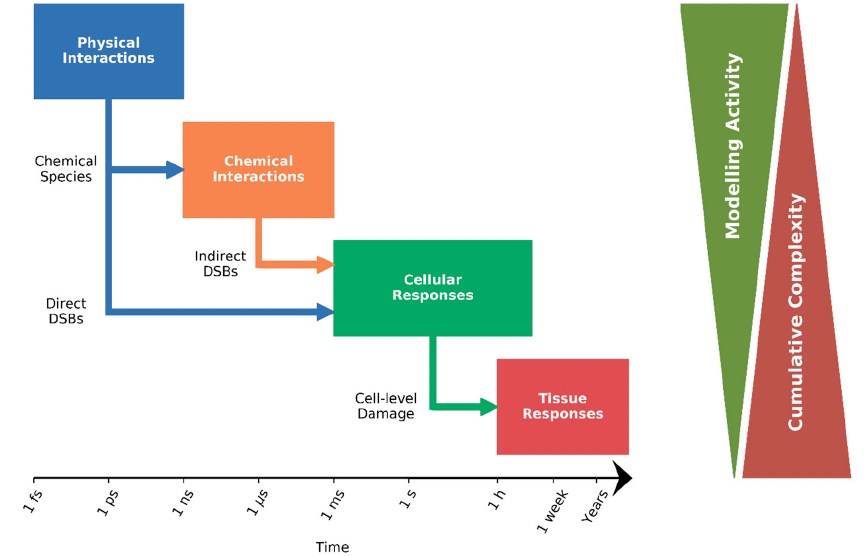
Figure 2. Illustration of stages of a comprehensive mechanistic response model, and approximate associated timescale. Early responses are dominated by physical interactions, models of which generate distributions of reactive chemical species, and direct DSBs generated in typically less than a nanosecond. These chemical species may also be included in a chemical interaction model, which generates predictions of indirect DSBs, over a scale of 1 ms or less. Responses at the cell level then take place over hours to days, as cells repair this damage and potentially respond by arresting, dying, or seeing other changes in function. Finally, tissue-level responses integrate such responses over a scale of hours to years, giving rise to clinically observable effects. Mechanistic modelling activity in radiotherapy has primarily focused early in this timescale, on physico-chemical and early cellular responses, with relatively little modelling of whole-tissue responses. This is in part due to the significant cumulative complexity in describing all aspects of these responses in a single